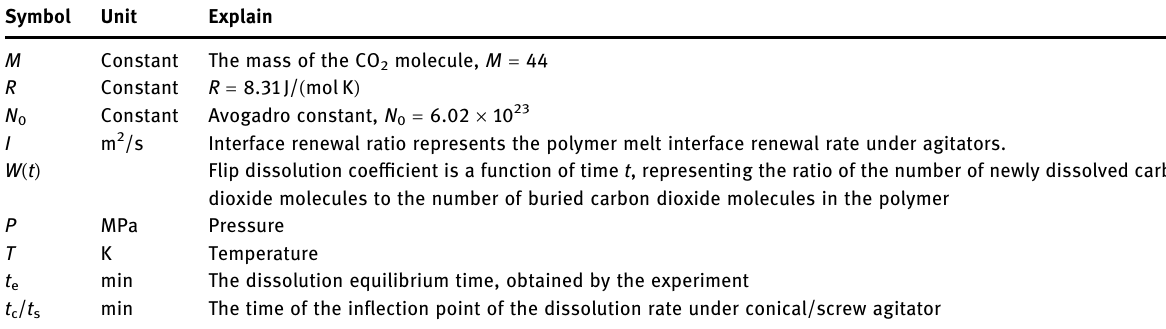
M = 44 2 molecule,